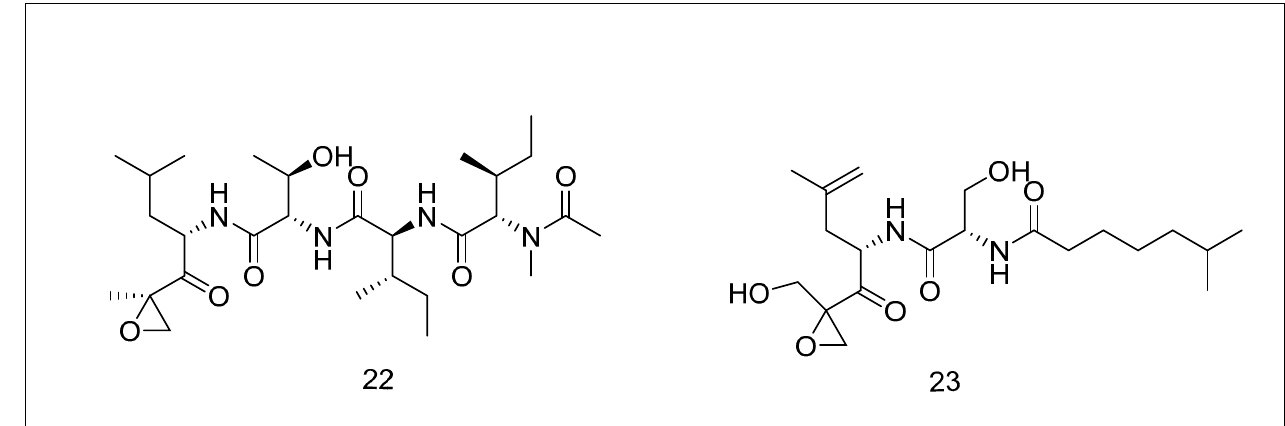
Figure 9. Chemical structures of epoxomicin ( 22 ) and eponemycin ( 23 ).